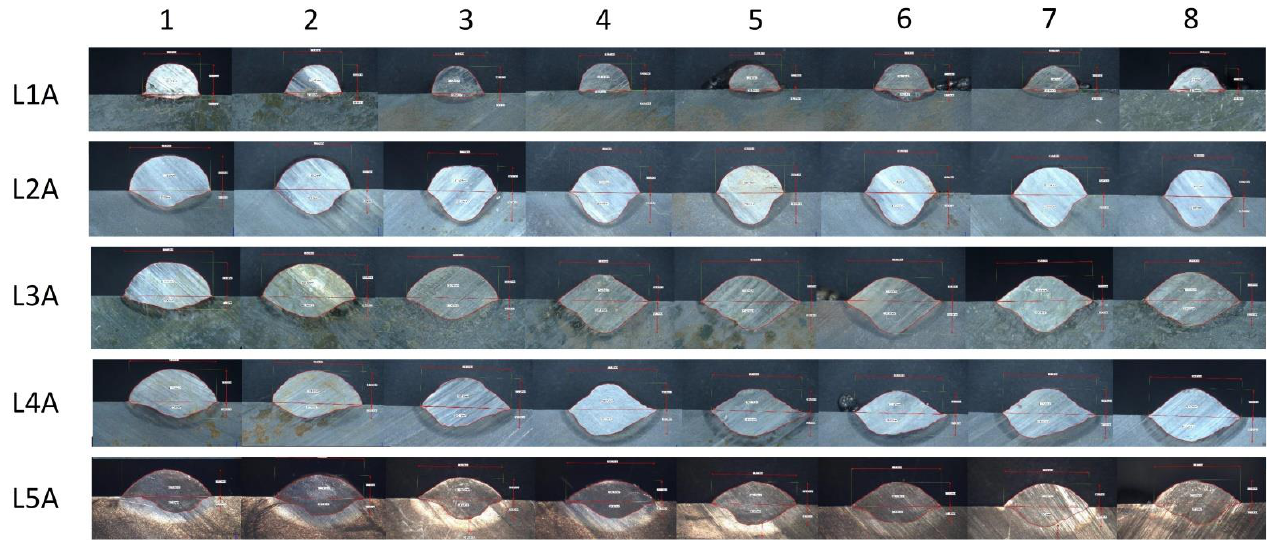
Figure 7. A collage of microscopic images collected for stringer bead of Wire A. The top row depicts lack of proper fusion, setting the lower limit for energy value for this material. 1 – 8 refer to the sample-cutting scheme, shown on Figure 3, L1A – L5A refer to Table 3.